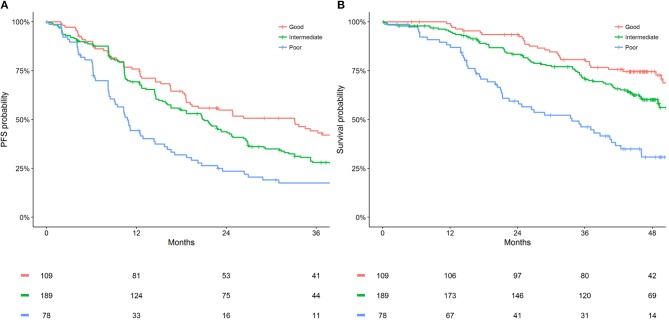
Kaplan Meier estimates of (A) PFS and (B) OS by pre-treatment prognostic groups for HER2-positive ABC patients who received first-line pertuzumab, trastuzumab and docetaxel within CLEOPATRA.